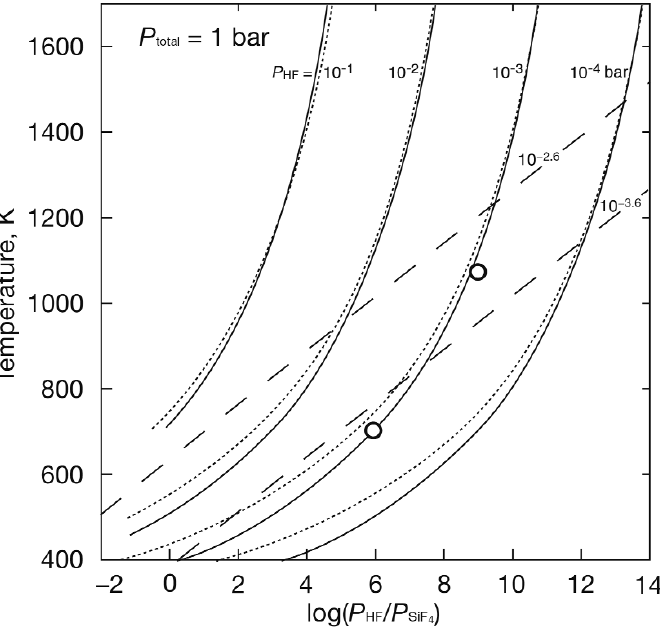
Fig. 2. Variation of SiF 4 /HF (expressed as log[ P HF / P SiF ]) with T (in K) at different partial pressures of HF, and 4 = 1). Continuous lines are from our own calculations, whereas dot- +P H 1 bar total vapour pressure (P HF +P SiF 4 2 O ted lines are data from Rosenberg (1973), dashed lines are after White and Hochella (1993), and the two circles are data points from Symonds et al. (1992) with P HF = 10 − 3.07 bar. Uncertainties in our data due to uncertainties in heat of formation and enthalpy of SiO 2 , HF, H 2 O and SiF 4 are about 25° and 0.2 log units. Note that the rel- ative importance of SiF 4 increases both with total amount of F in the system ( i.e. , P HF ), and with decreasing tem- perature. White and Hochella (1992) trends are clearly offset and predict HF/SiF 4 variations with temperature that are much larger than other